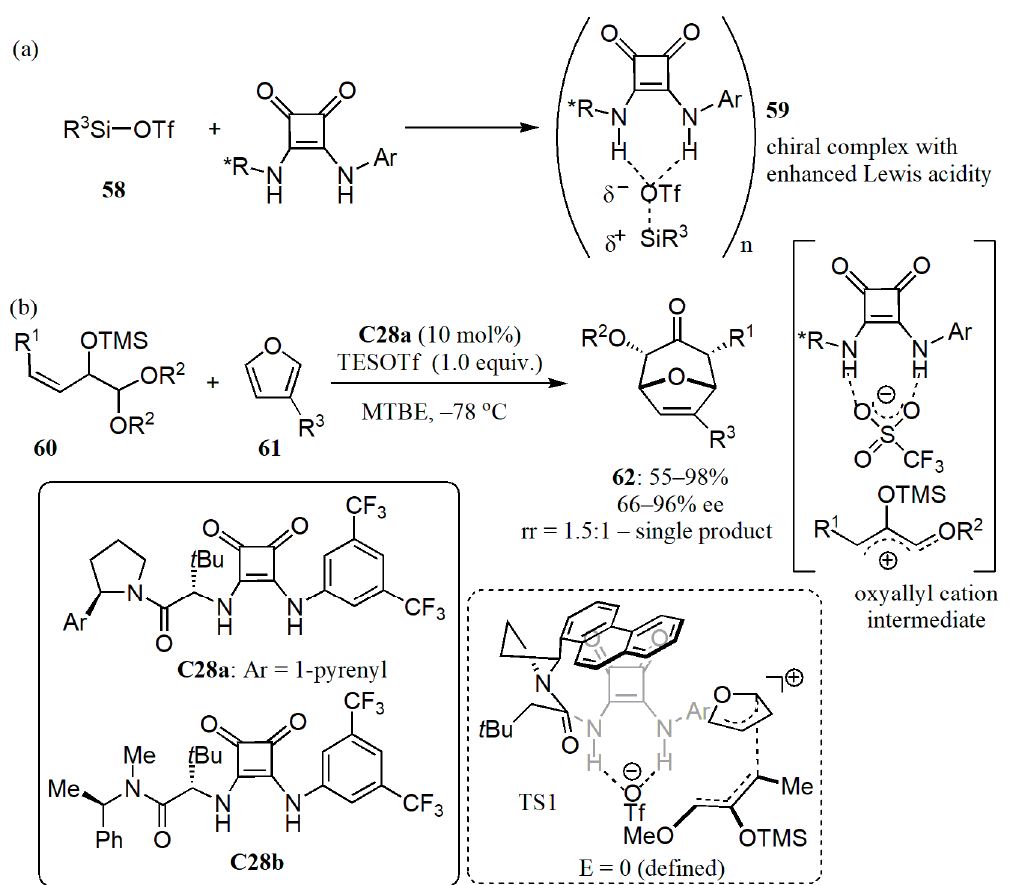
Figure 36. ( a ) Activation of a silyl triflate ( 58 ) via anion abstraction by a squaramide catalyst; ( b ) Application of the type of activation shown in (a): Cooperative reactivity of squaramide-based catalyst C28a and TESOTf in enantioselective [4+3] cycloadditions via oxyallyl cation intermediates; r.r. is the regioisomeric ratio [70].